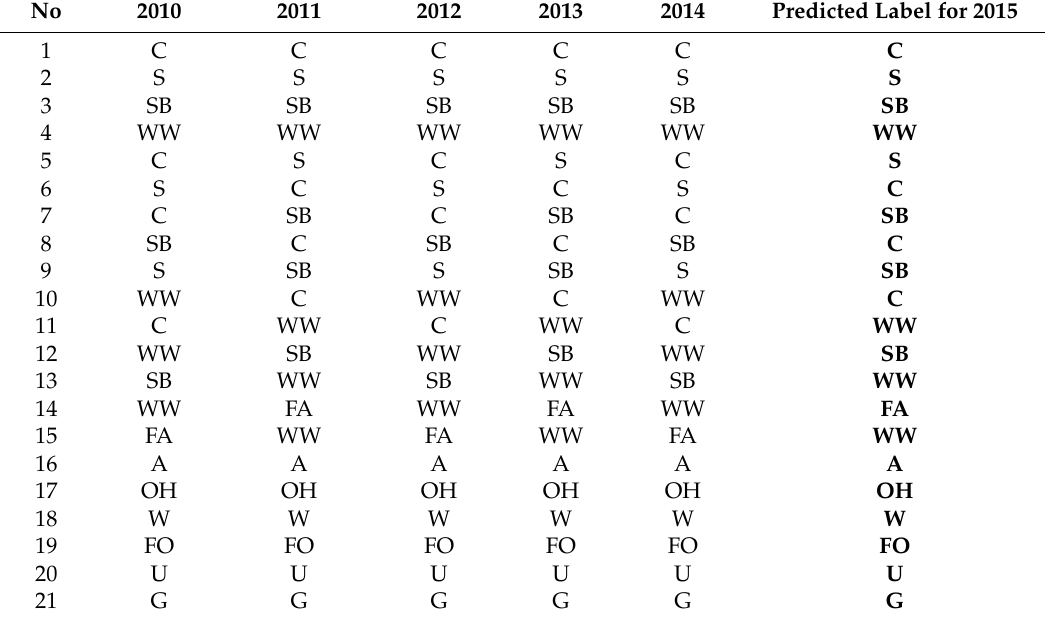
Table 3. Sequential patterns of land-covers between 2010 and 2014 (C: corn, S: sorghum, SB: soybean, WW: winter wheat, A: alfalfa, OH: other hay, FA: fallow, W: water, U: urban, FO: forest, G: grass). The class labels in 2015 predicted from CDLs spanning the past five years are shown in